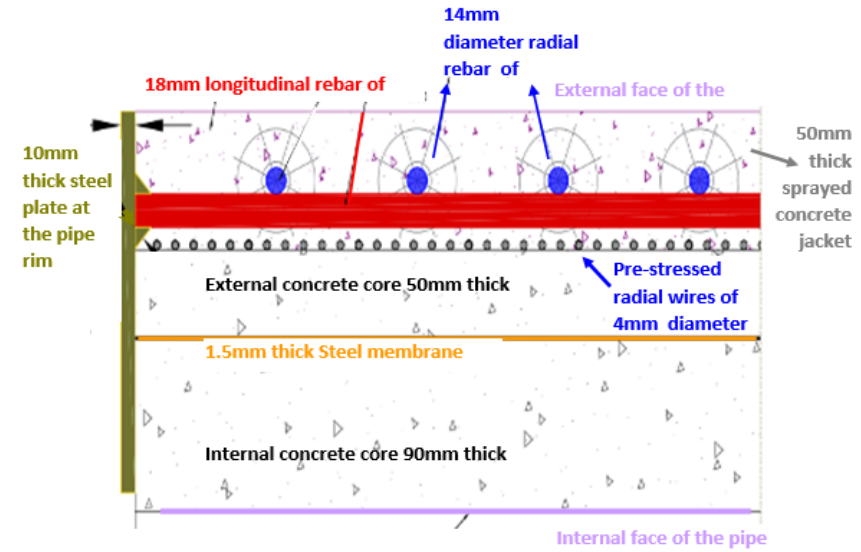
Figure 8. Cross ‐ section of the PCCP pipe with active prestressing wires and external RC jacket.